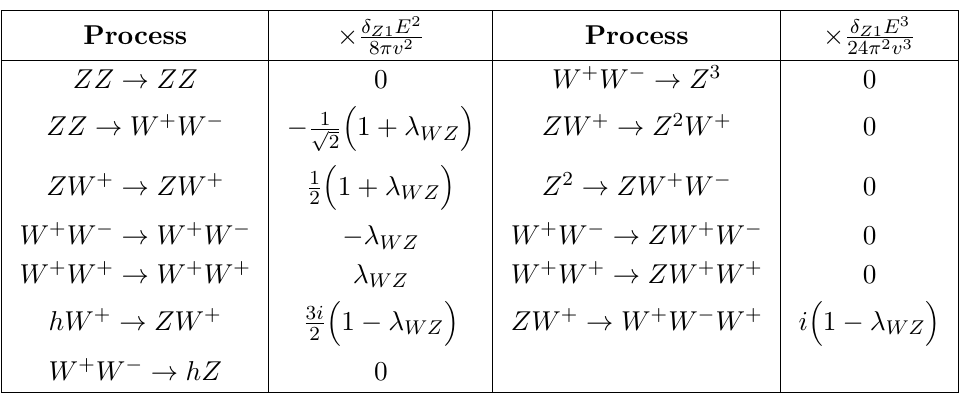
Table 2 . 5-body unitarity-violating processes that depend on δ V 2 and δ V 1 . One can see that the dim-6 SMEFT prediction δ = 4 δ gives vanishing amplitudes for all processes. V 2 V 1